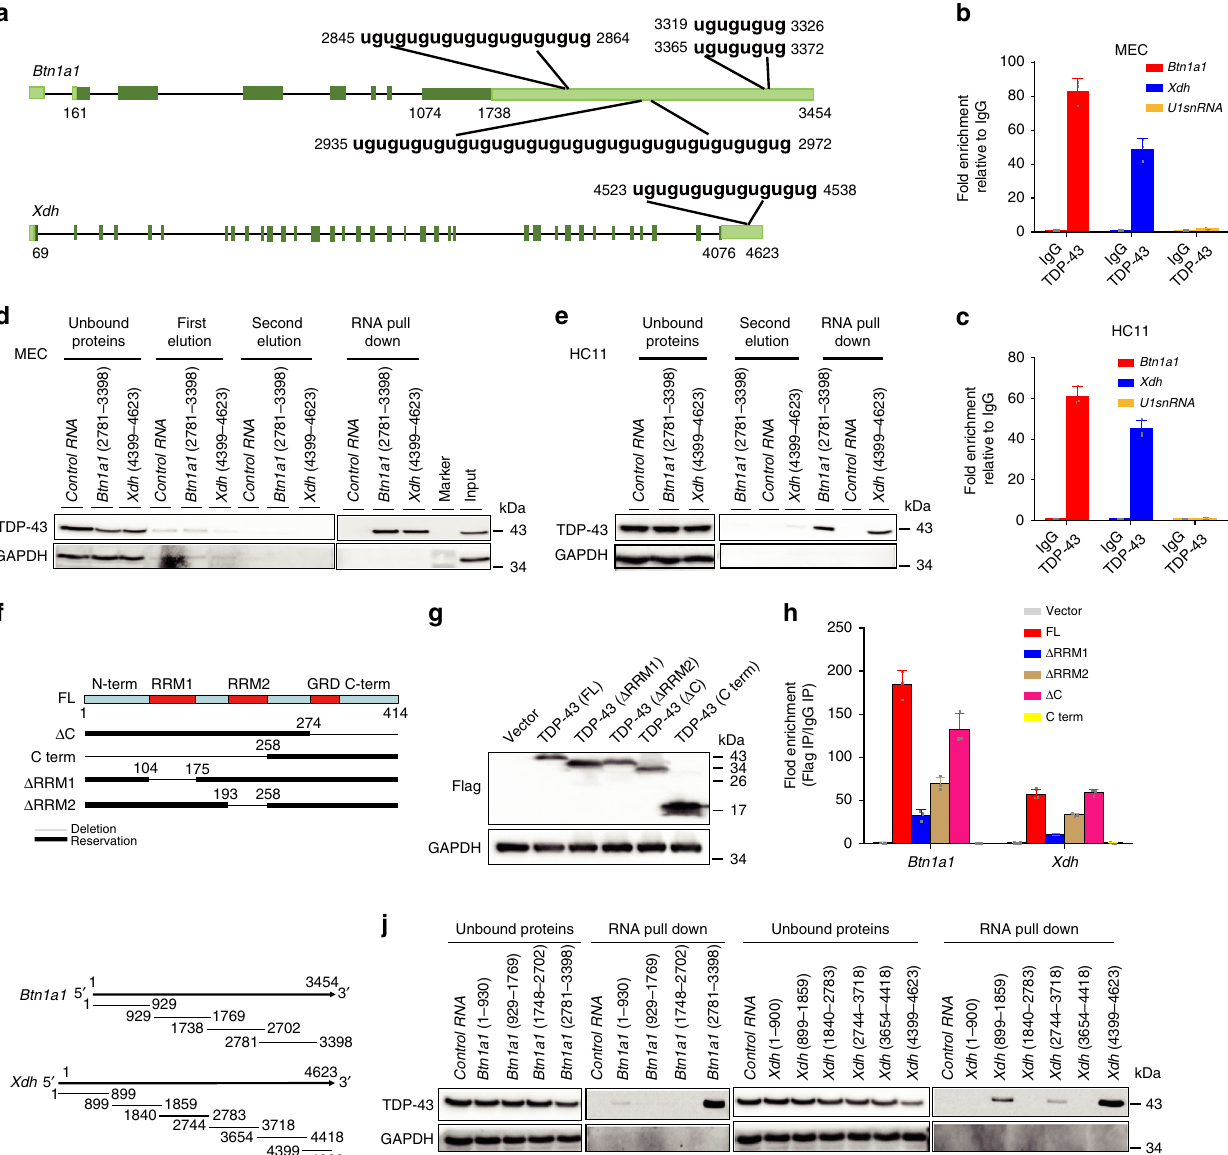
Fig. 5 TDP-43 directly binds to Btn1a1 and Xdh mRNA. a mRNA structures of Btn1a1 (upper) and Xdh (lower) showing TDP-43-binding motif in 3 ′ -UTRs. Deep green boxes represent coding region. Light green boxes represent non-coding region. b , c RNA immunoprecipitation (RIP) assay for analysis of interaction between TDP-43 protein and Btn1a1 or Xdh mRNA in MECs and differentiated HC11 cell line using TDP-43 antibody. d , e MECs ( d ) and differentiated HC11 ( e ) cellular extracts were incubated with in vitro-transcribed biotin-labeled control (pcDNA3.1 vector), Btn1a1 , or Xdh mRNA fragments for biotin RNA pull-down followed by western blot analysis. Control RNA used biotinylated RNA without TDP-43-binding site (ugugug). f Structures of TDP-43 and their mutants used in RIP assays. TDP-43 protein contains an N-terminal domain (N-term), two RNA-recognition motifs (RRM1 and RRM2), a glycine-rich domain (GRD), and a C-terminal domain (C-term). g Western blot of overexpressed Flag-TDP-43 or its mutants in HC11 cell line. h RIP assay using Flag antibody in differentiated HC11 cells after overexpression of Flag-TDP-43 or Flag-mutants of TDP-43. i Schematic of mouse Btn1a1 or Xdh mRNA fragments used for RNA pull-down assays. j Binding between TDP-43 protein and fragmented Btn1a1 and Xdh mRNA. Four biotinylated Btn1a1 mRNA fragments or six biotinylated Xdh mRNA fragments were incubated with HC11 cellular extract, and interaction between TDP-43 and each fragment was examined by RNA pull-down followed by western blot analysis. Data are shown as the means ± SD of three independent experiments. Source data are provided as a Source Data fi